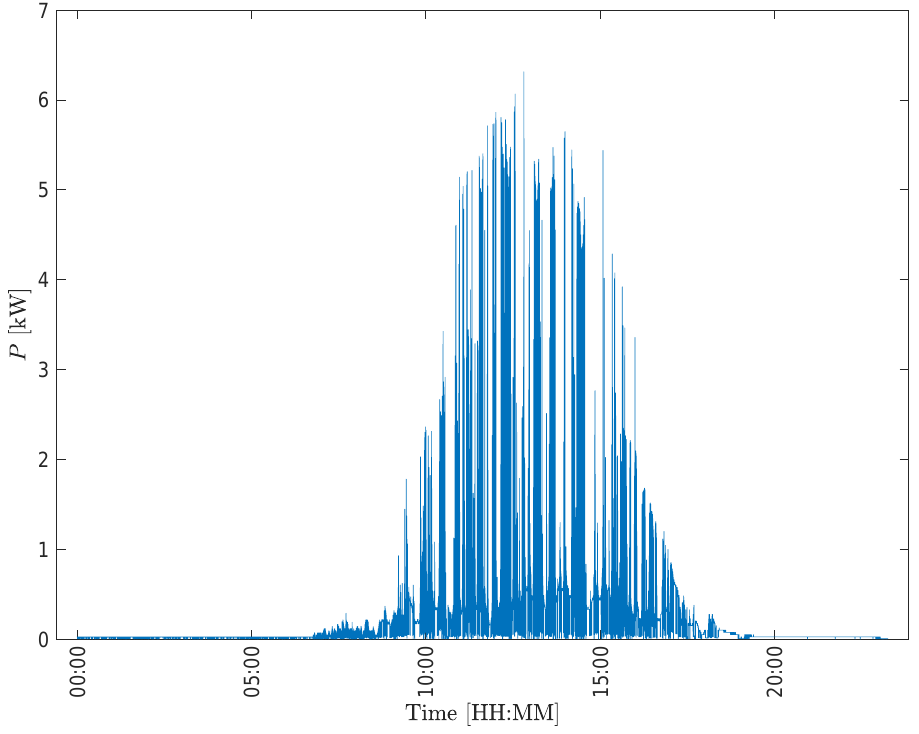
Figure 4. Sample data from a photovoltaic installation.